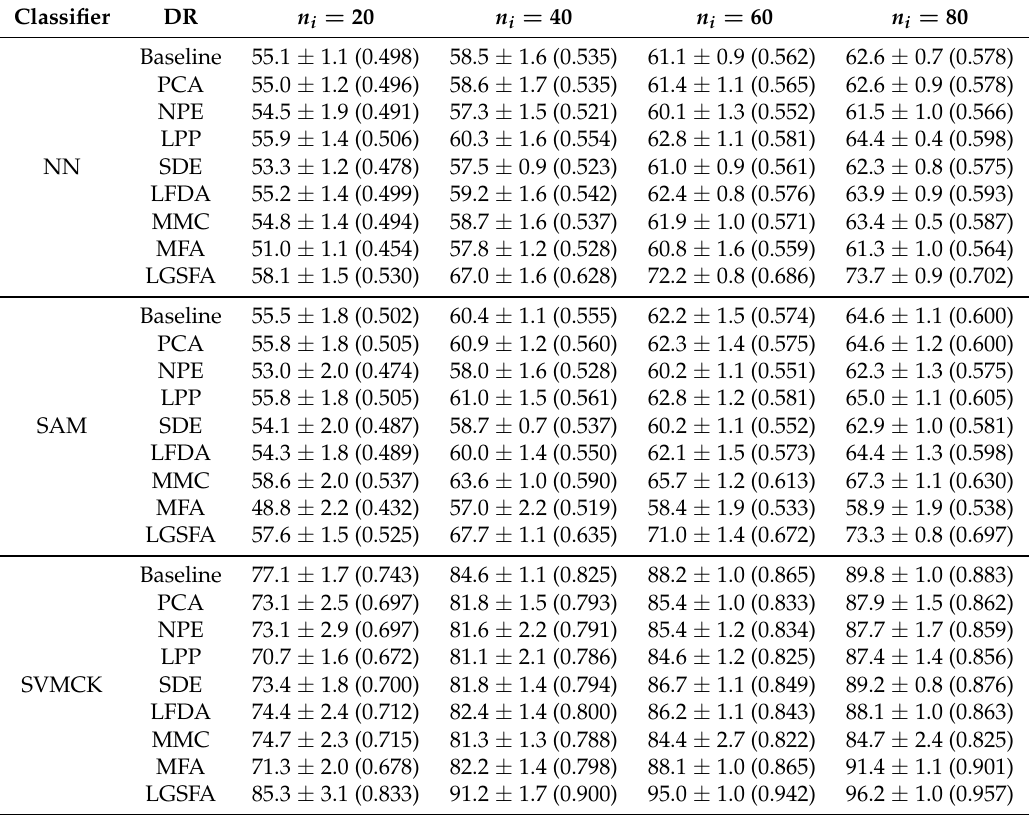
Table 3. Classification results with different numbers of training samples on the Indian Pines data set (OA ± std (%)